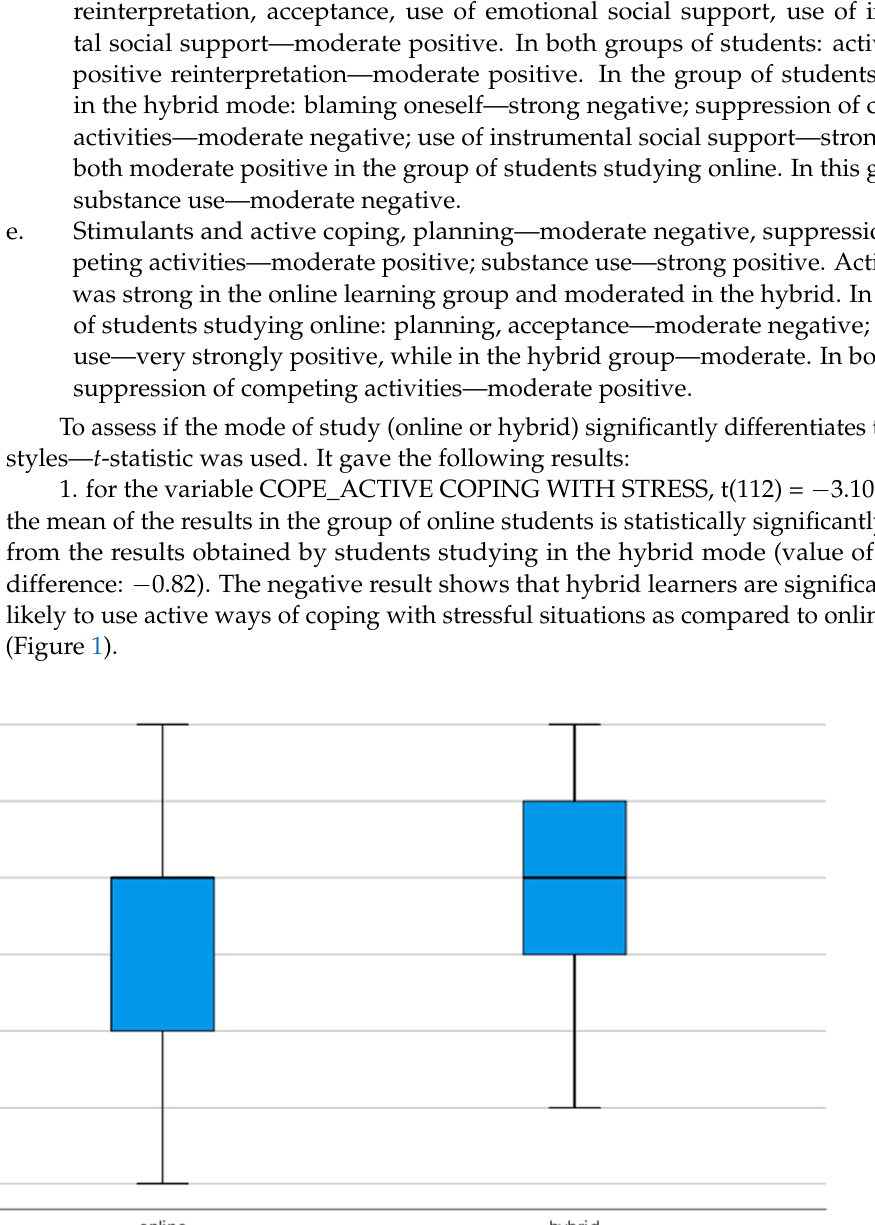
Figure 2. For the variable COPE_PLANNING.